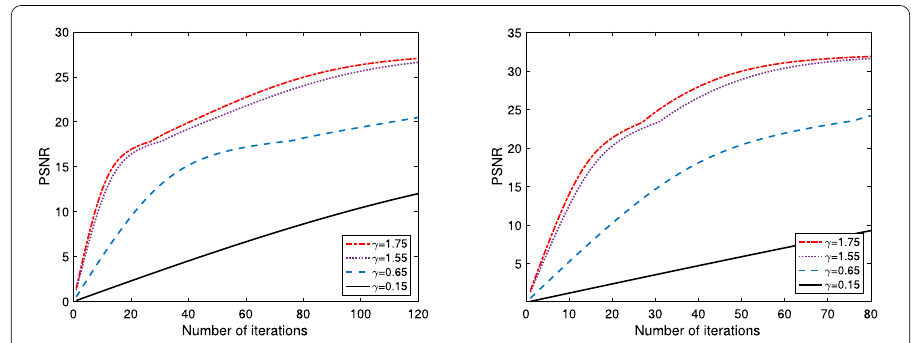
Figure 10 Graph of PSNR value and number of iterations